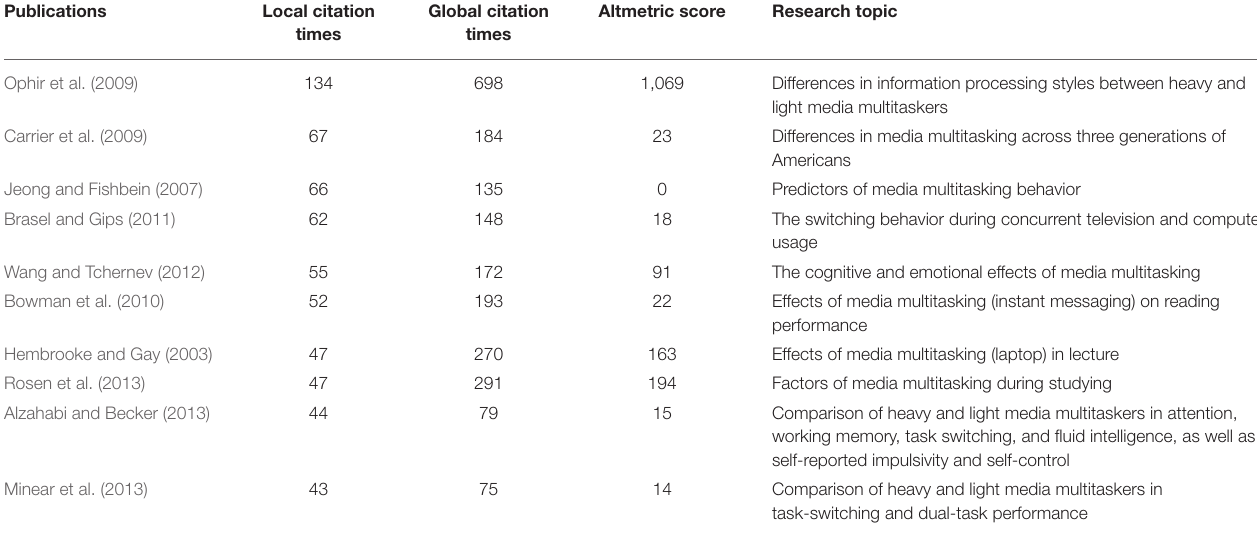
TABLE 4 | The ten most cited media multitasking